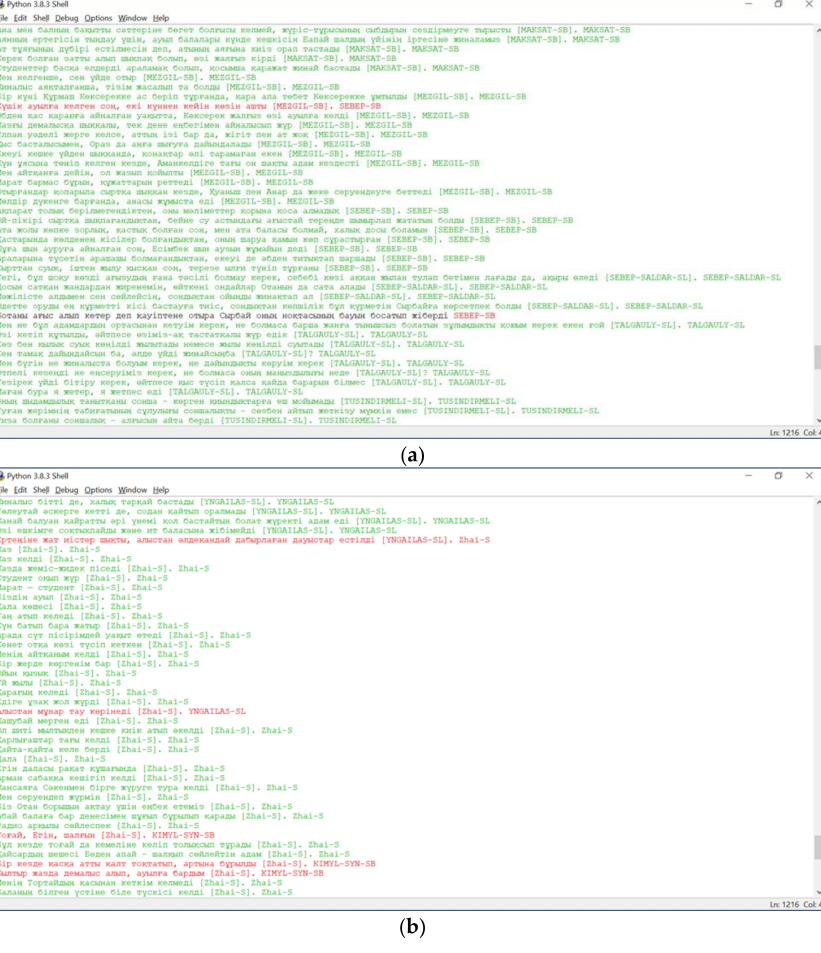
Figure 2. ( a , b ) Results of the program for determining the type of a complex